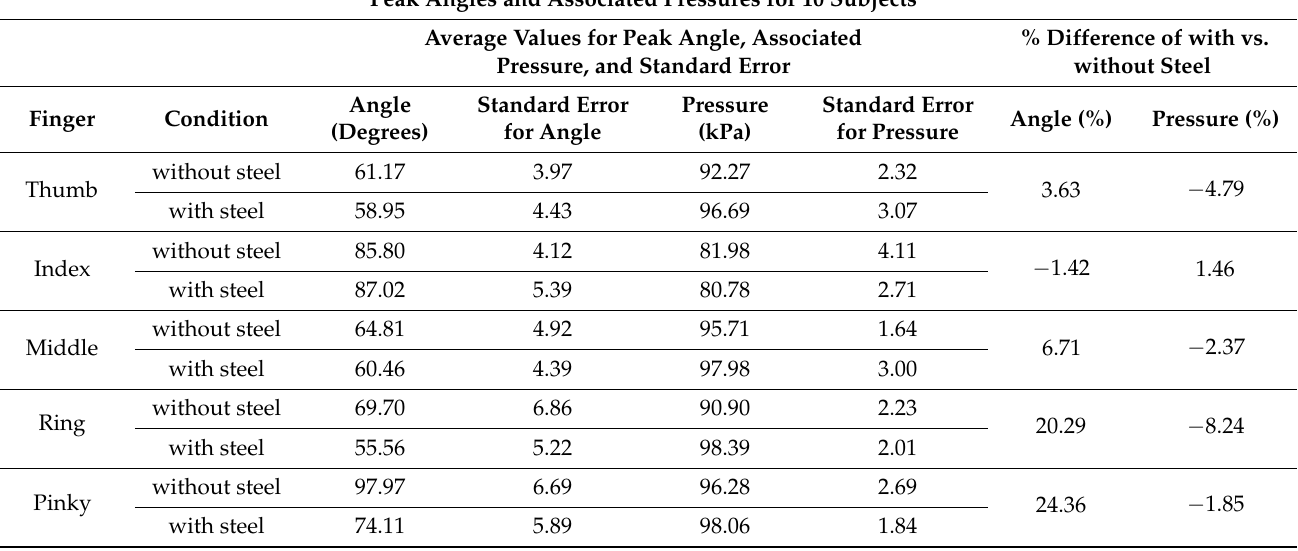
Table 4. Average peak angles and associated pressure values averaged for 10 subjects for each of the 5 fingers compared between 2 conditions of pneumatic actuator with and without the steel layer. Peak Angles and Associated Pressures for 10 Subjects Average Values for Peak Angle, Associated % Difference of with vs. Pressure, and Standard Error